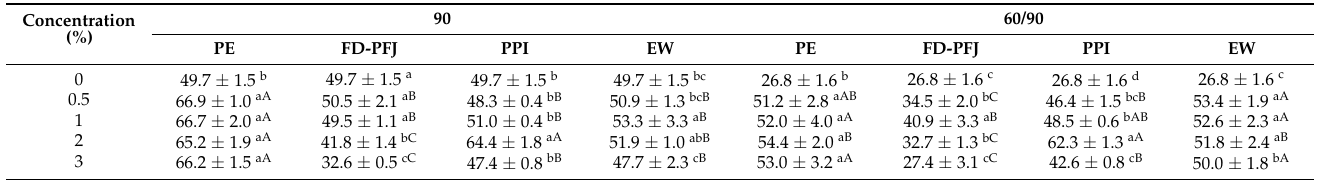
Table 4. Water retention ability of the Pacific whiting surimi gels with four different inhibitors (PE, FD-PFJ, PPI, and EW) at 0, 0.5, 1, 2, and 3% levels heated to 90 ◦ C directly (90) and held at 60 ◦ C for 30 min prior to heating to 90 ◦ C (60/90).